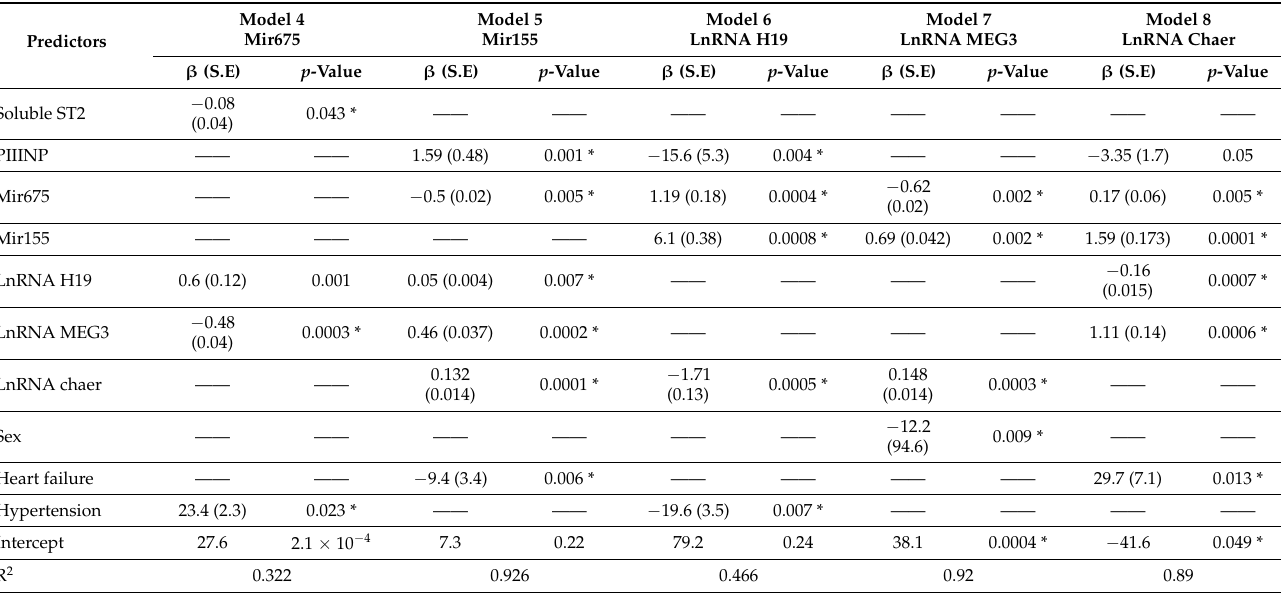
Table 12. Predictors of mircro RNAs and non-coding RNAs